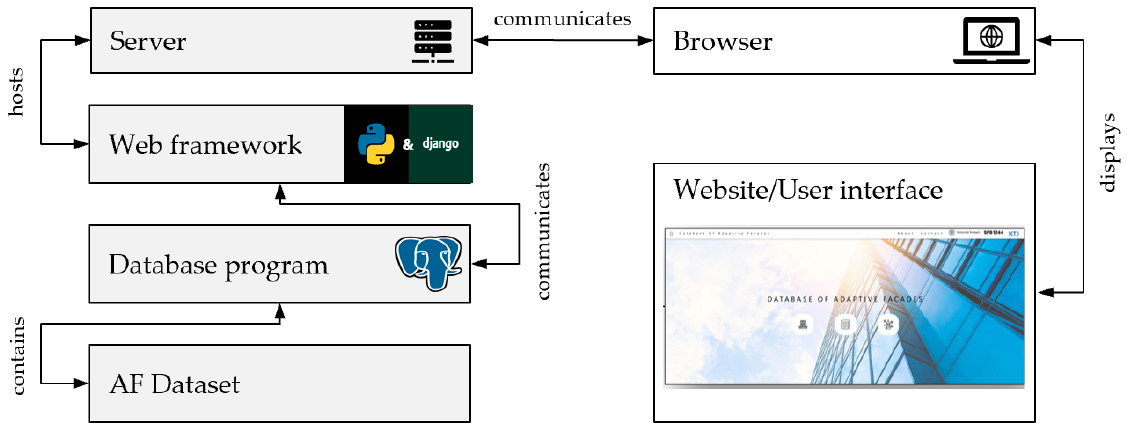
Figure 13. The program structure of the web-based database.